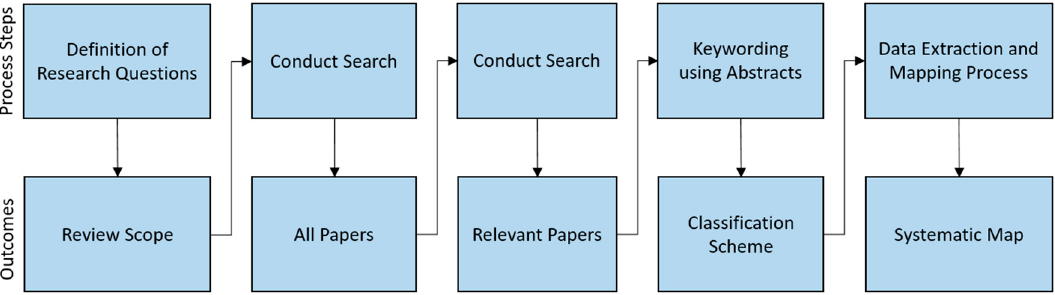
Figure 3. The systematic mapping process steps.